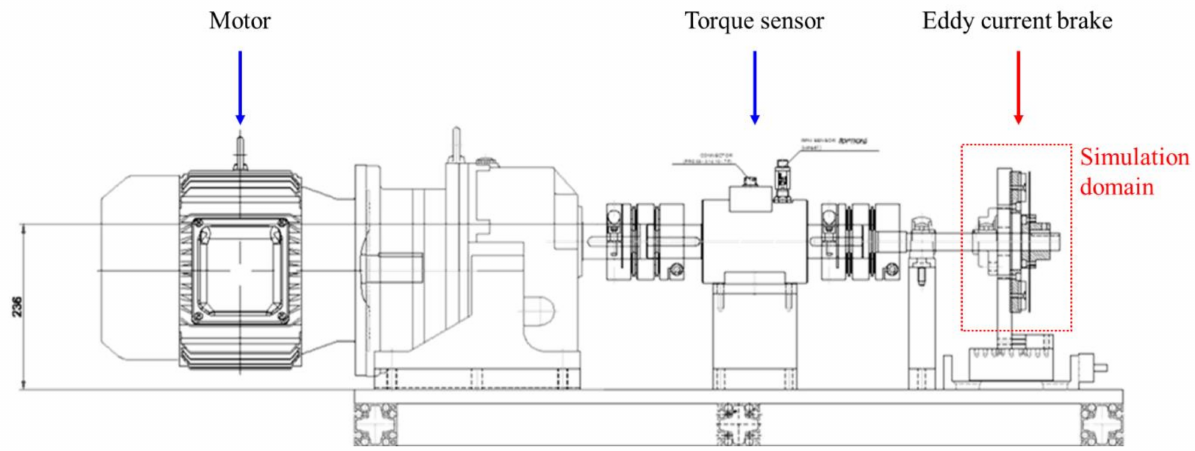
Figure 2. ECB test rig.